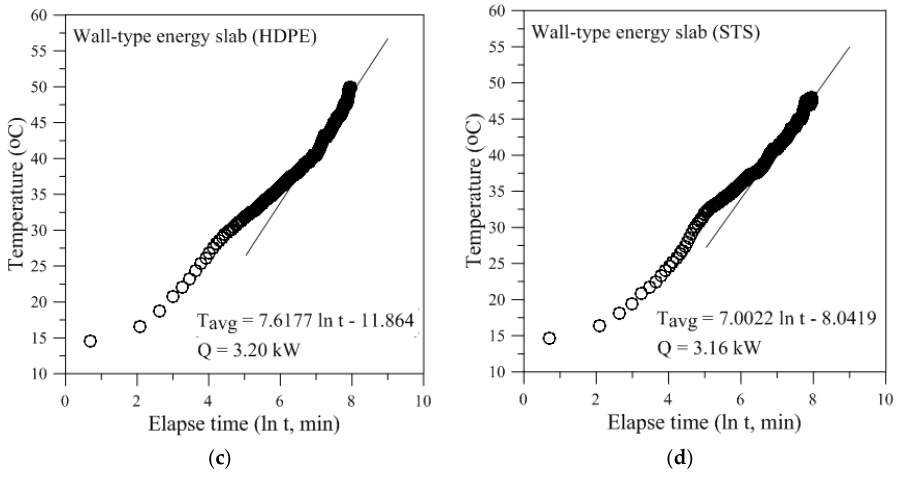
Figure 10. Results of in-situ thermal response tests (TRTs) for energy slab (average temperature changes of inlet and outlet versus natural logarithm of time). ( a ) Floor-type energy slab (high-density polyethylene (HDPE)); ( b ) Floor-type energy slab (stainless steel (STS)); ( c ) Wall-type energy slab (HDPE); ( d ) Wall-type energy slab (STS).